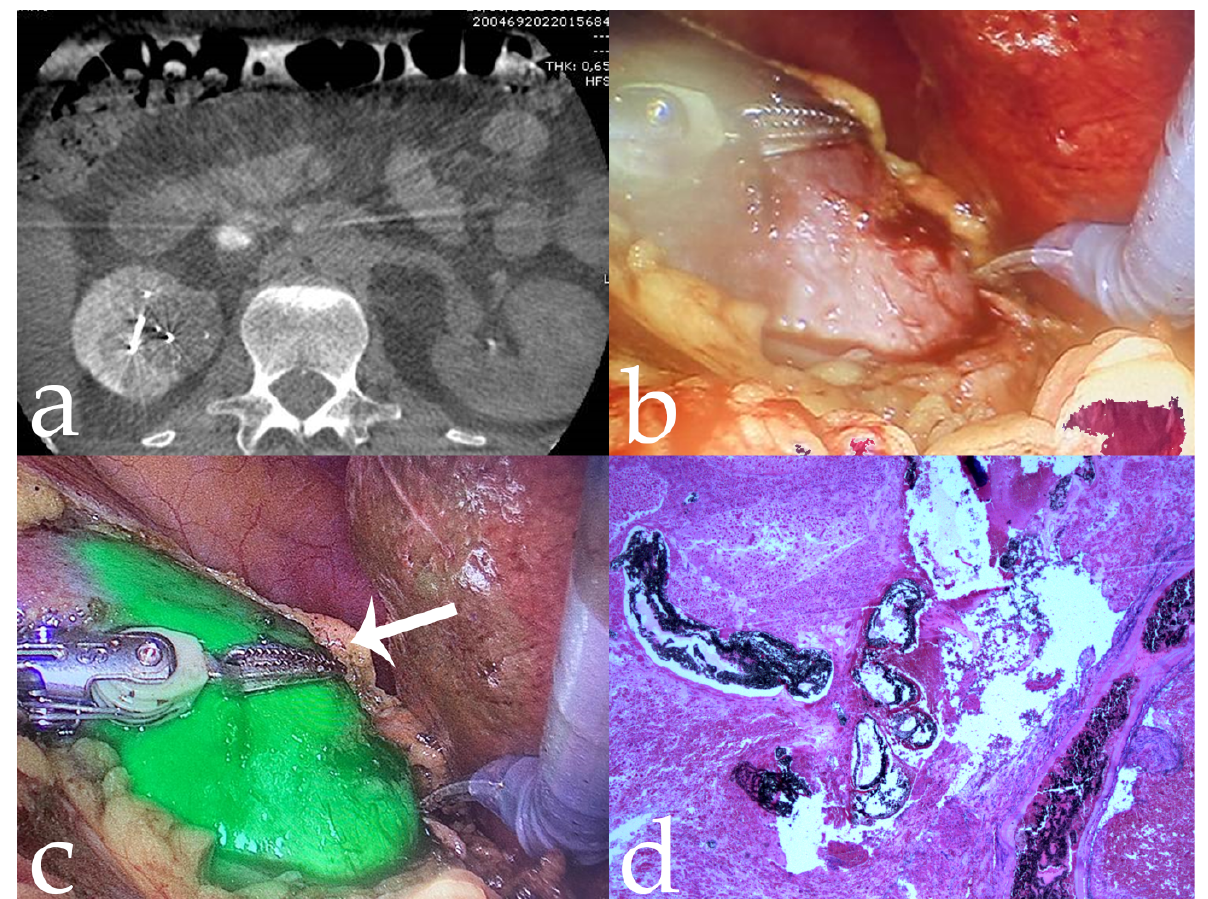
Figure 7. Same case as Figure 6. ( a ) Post-procedural CBCT showing complete tumour devascularization; ( b , c ) Tumor visualization before and after fluorescence imaging, during robotic-assisted partial nephrectomy (arrow); ( d ) surgical specimen with intralesional distribution of mixture embolic agent (10×).